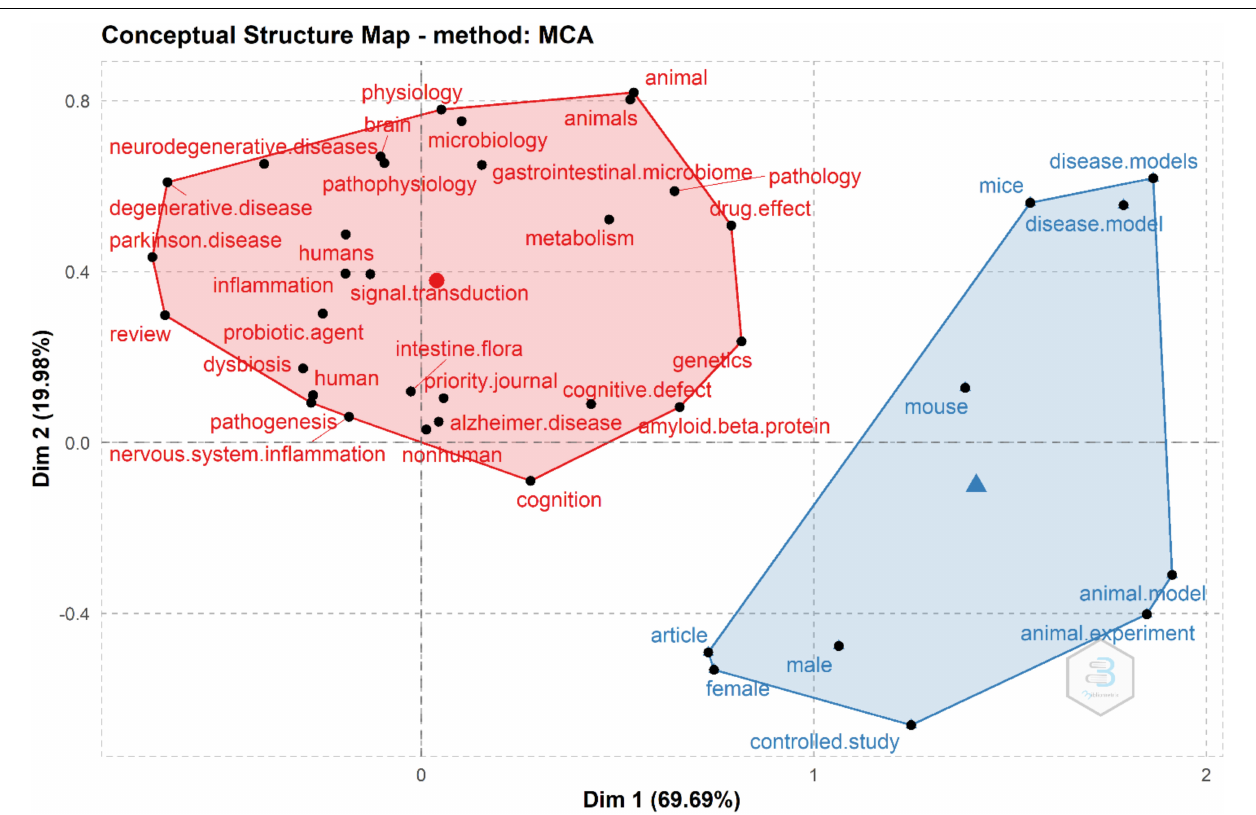
FIGURE 8 | Conceptual structure map. We observe two clusters, the one related with mouse models on the relationship between the gut microbiome and AD, and the other that studies the gut microbiome composition and dysbiosis with or without the impact of other methods in humans like probiotic agents for the restoration of cognition and reduction of amyloid- β